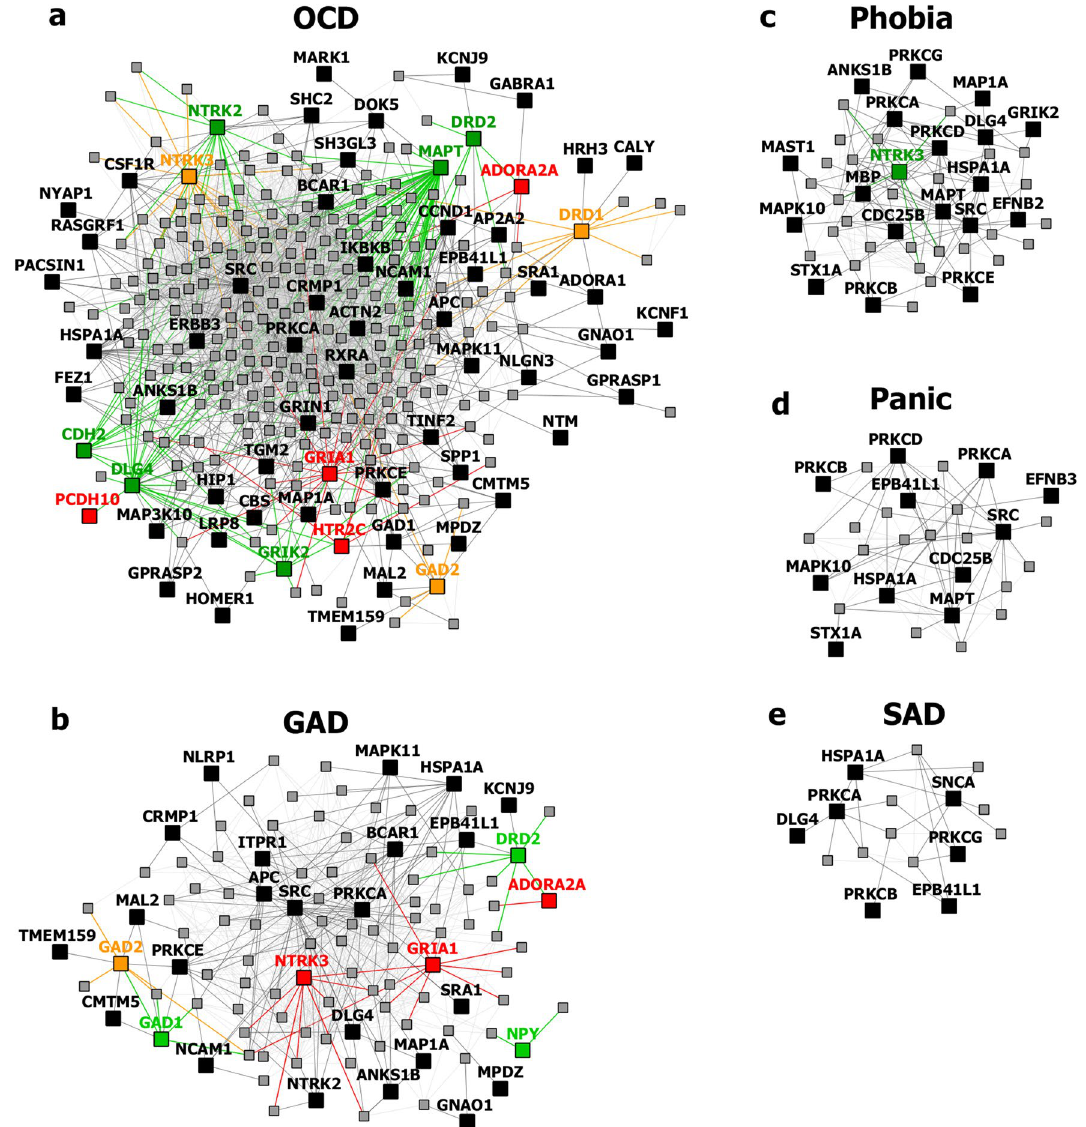
Figure 8. Network layout of the genes expressed in the influential brain regions in the AD-SMIs. The network diagrams show the genes having moderate/high expression in the four brain regions that were highly influential in identifying the disorder groups shown in Fig. 4c, namely, amygdala, hippocampus, ACC and nucleus accumbens. These genes have been highlighted in ( a ) OCD interactome, ( b ) GAD interactome, ( c ) phobia interactome, ( d ) panic disorder interactome and ( e ) SAD interactome. In each of the network diagrams, green colored nodes depict genes associated with the particular AD. Red colored nodes indicate genes differentially expressed in striosomes/matrix that shows interactome overlap with the given AD; ( a ) OCD and ( b ) GAD shows interactome overlap with striosome, whereas ( c ) phobia, ( d ) panic disorder and ( e ) SAD show overlap with matrix. Orange colored nodes indicate genes that are associated with the particular AD as well as differentially expressed in the striatal compartment. Black colored nodes are intermediary genes interconnecting the AD genes. The majority of the red and black colored nodes shown in the diagrams, i.e. genes that are yet to be studied in the context of human ADs, have already been linked to anxiety-like/repetitive/perturbed social behavior in animal models and humans (see Table 2). The validity of these genes as candidates for further investigation of anxiety mechanisms is supported by this evidence and their proximity in the interactome to genes that have been previously associated with human ADs (i.e., green colored nodes). The network diagrams were created using Cytoscape (version